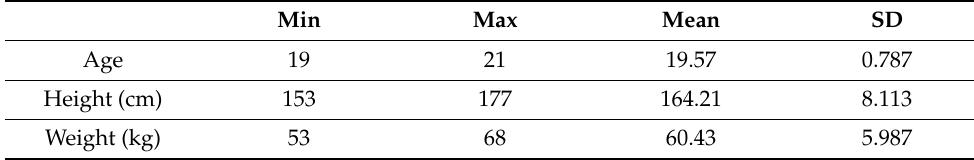
Table 1. Subject’s demographic distribution (n =